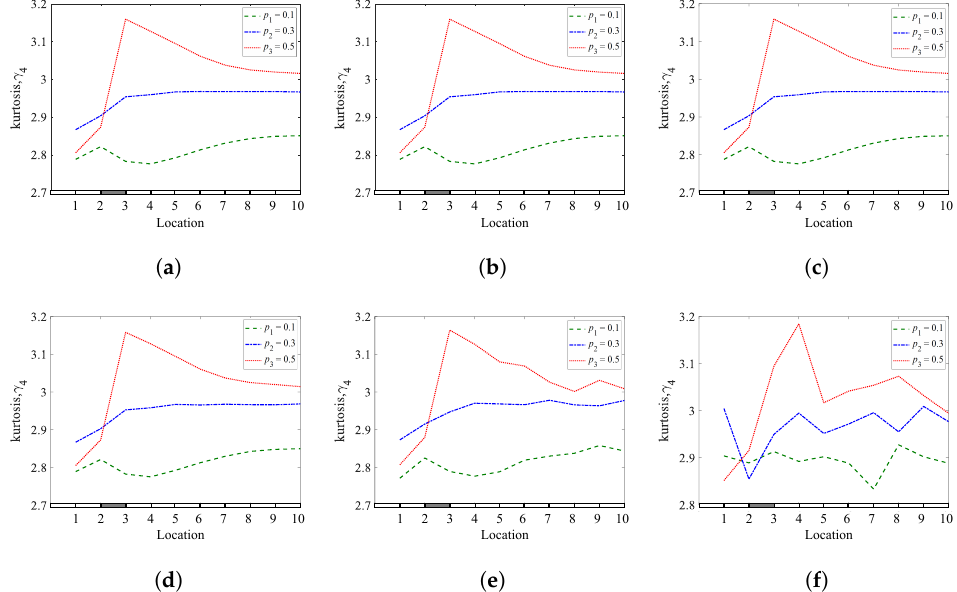
Figure 36. The effect of noise levels on kurtosis coefficients of a cantilever beam: ( a ) Noise-free; ( b ) SNR = 85 dB; ( c ) SNR = 65 dB; ( d ) SNR = 45 dB; ( e ) SNR = 25 dB; ( f ) SNR = 10